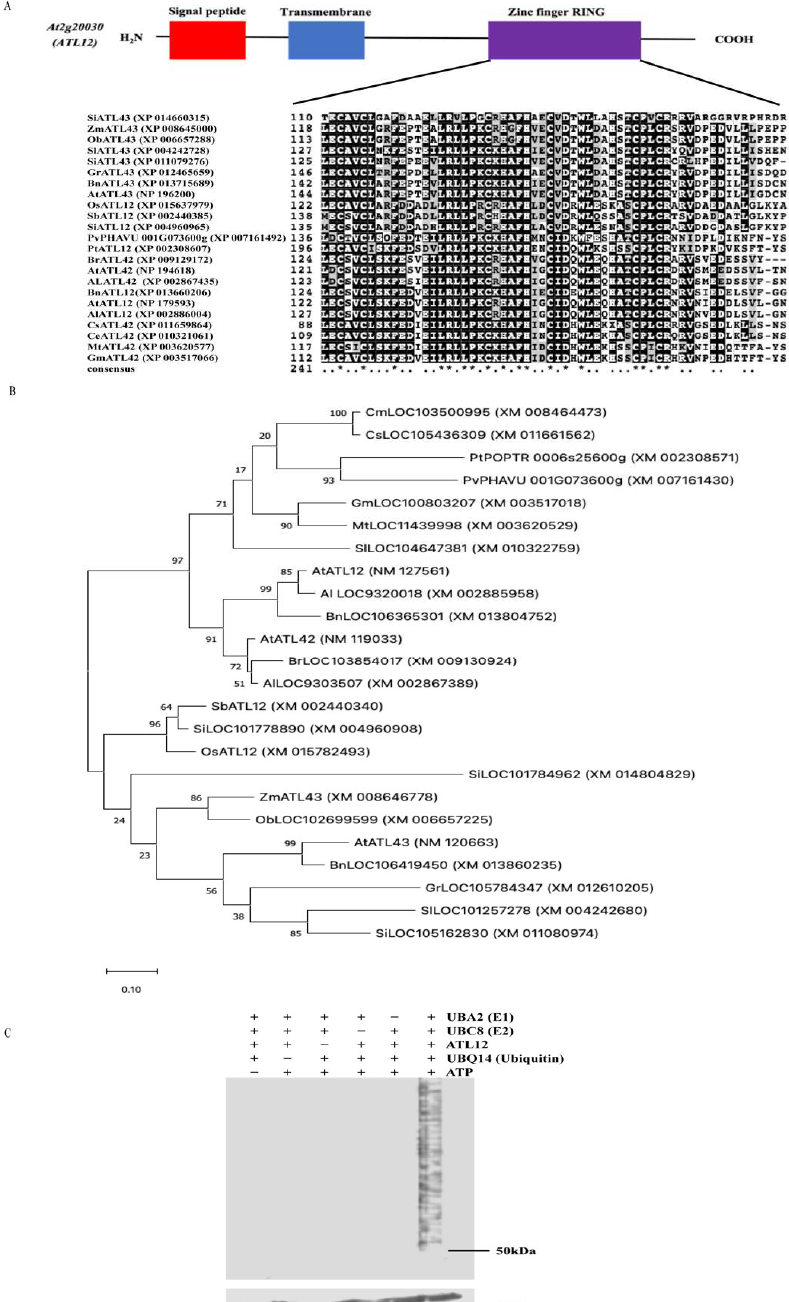
Figure 1. Characterization of ATL12 and the protein sequence and phylogenetic analysis of ATL12. ( A ) Schematic structure of ATL12; Amino acid sequence of ATL12. Red color fonts indicate signal peptide; Blue color fonts indicate transmembrane domain and purple color font show zinc finger RING domain. ( B ) Phylogenetic analysis of the ATL12 homologs. Bootstrap values from 1000 repli- cates are indicated at each node and the scale represents branch lengths. ( C ) In vitro ubiquitination assay of ATL12. ATL12 was assayed for E3 activity in the presence of E1 (ATL12), E2 (UBC8), and 6× His tagged ubiquitin. Samples were separated by 4–20% SDS-PAGE. Anti-ubiquitin antibody was used to detect in western blotting.